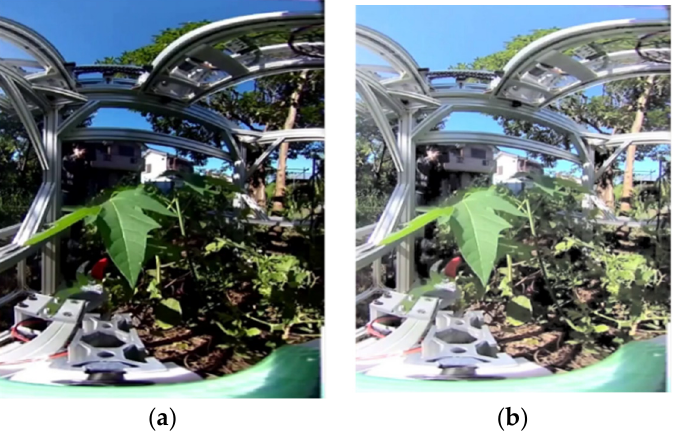
Figure 14. ( a ) Normal image, ( b ) Gamma correction. Comparison of environmental image correc- tion.